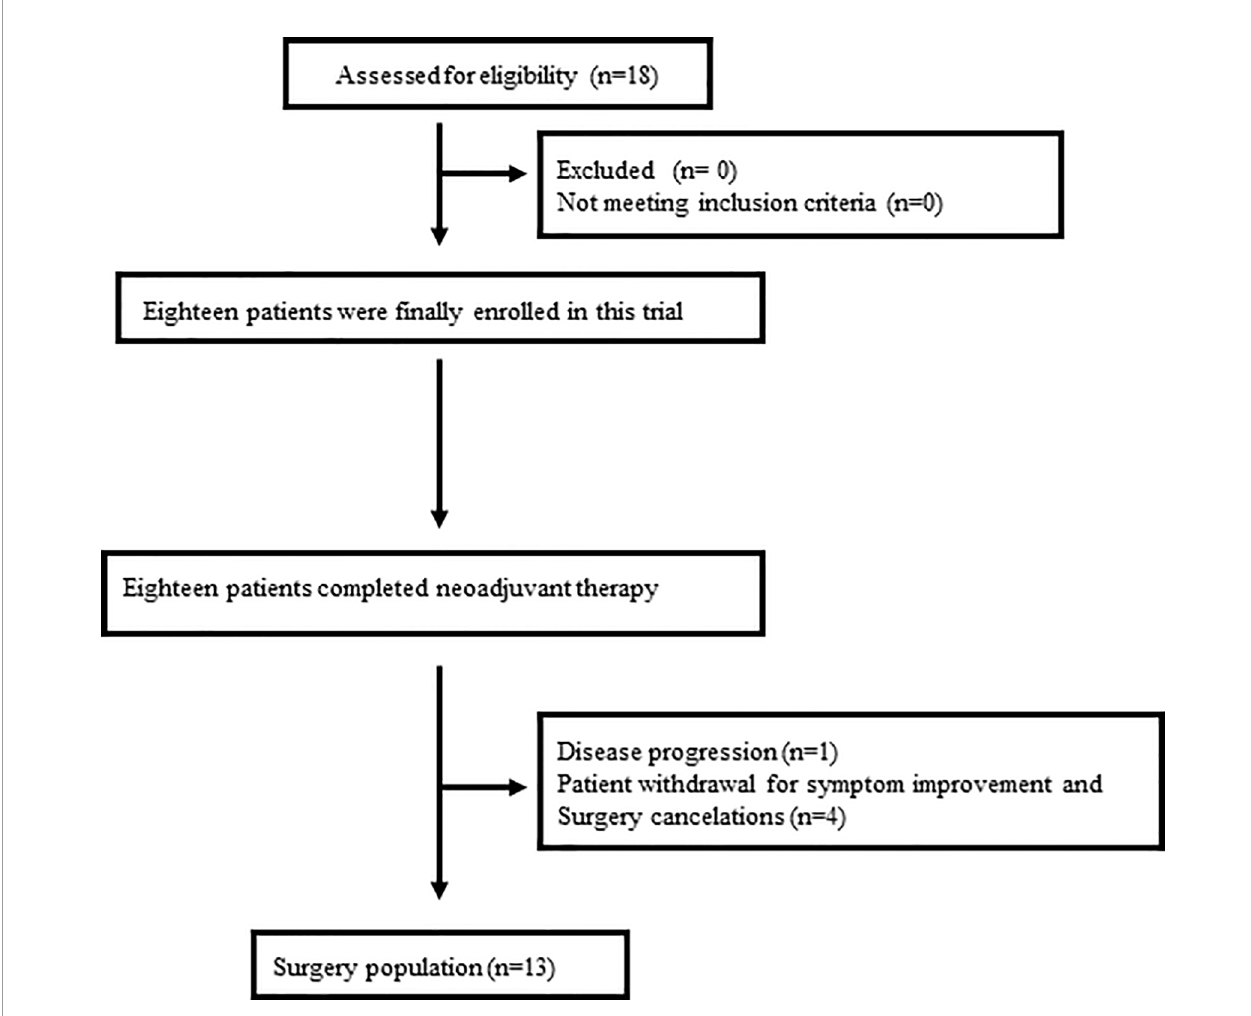
FIGURE 1 | Patients